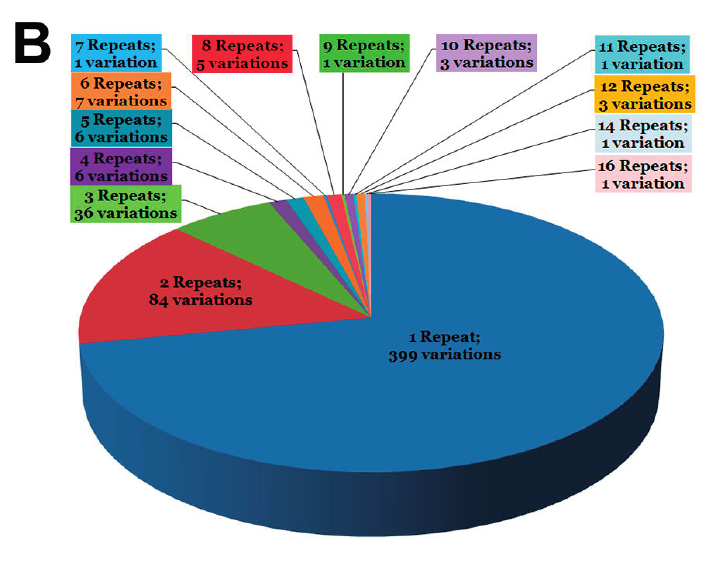
Figure 2. Representation of cases and variants. ( A ) Distribution of samples in the cohort; ( B ) Distribution of variants grouped by number of repetitions in the cohort. SUD: Sudden Unexplained Death; SIDS: Sudden Infant Death Syndrome; ARVC: Arrhythmogenic Right Ventricular Cardiomyopathy; DCM: Dilated Cardiomyopathy; HCM: Hypertrophic Cardiomyopathy; LQT: Long QT Syndrome; CPVT: Catecholaminergic Polymorphic Ventricular Tachycardia; SQT: Short QT Syndrome; BrS: Brugada Syndrome; LVNC: Left Ventricular